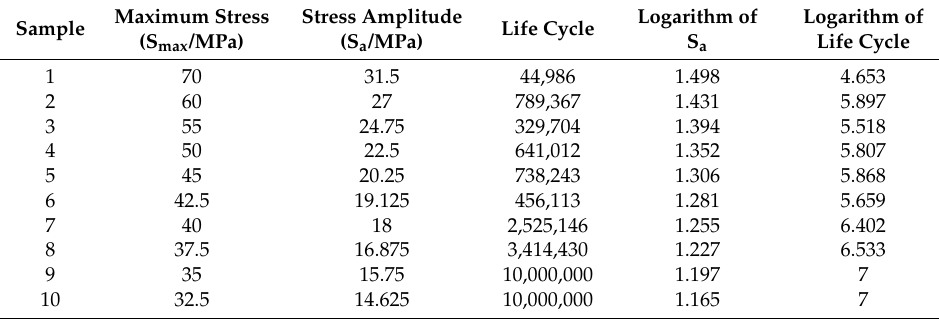
Table 4. Fatigue-test